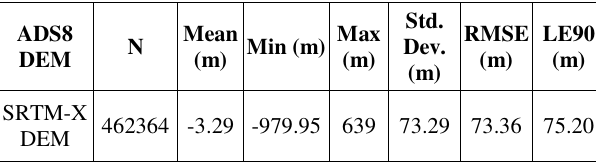
Table 3: Statistical Summary of Difference/ Error DEM